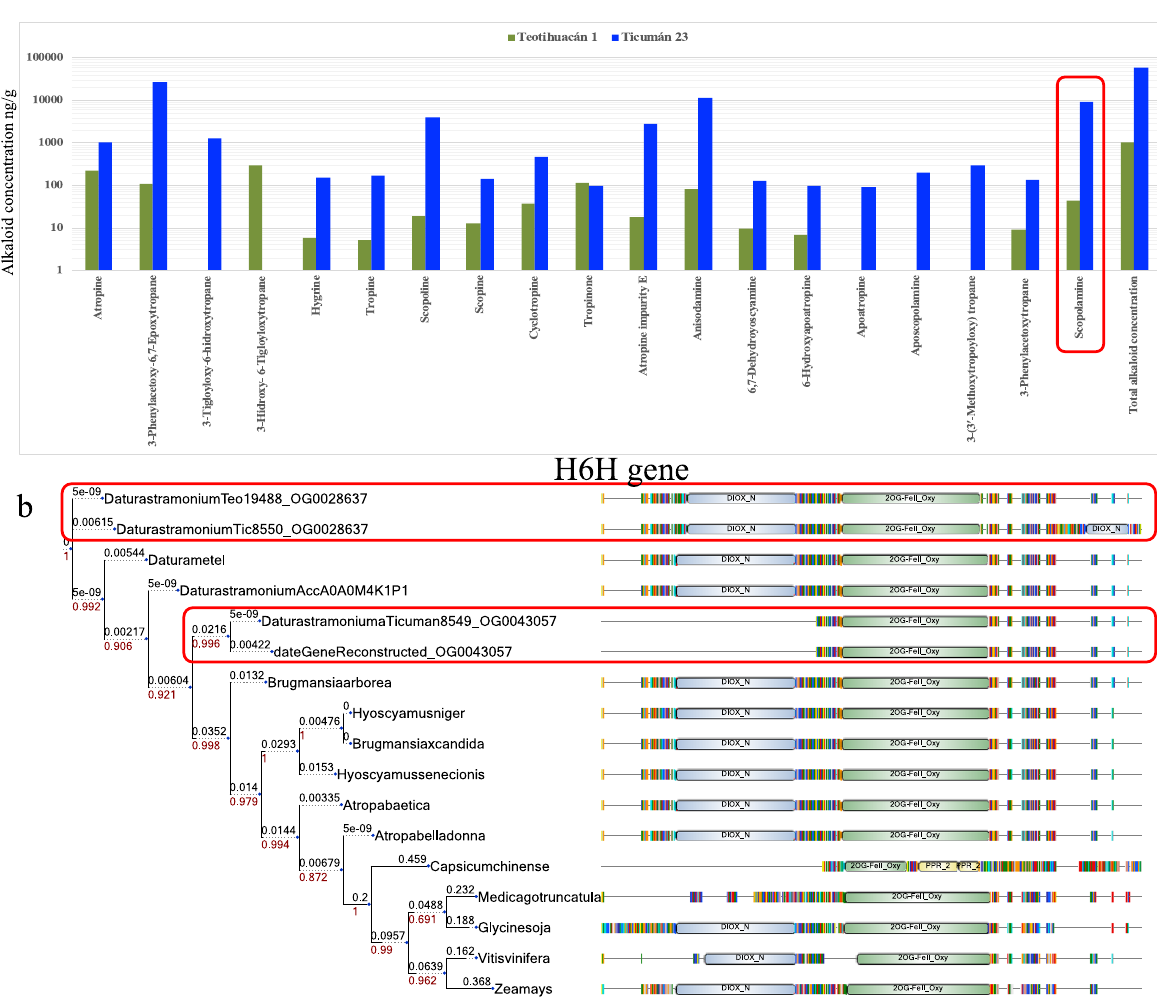
between Ticumán and Teotihuacán (Supplementary Table S17 online, Fig. 5a). Thus, it is possible that the additional domain of spermine-synthase confers overproduction of tropane alkaloids in the Ticumán genome. No expansion was detected for tpr I gene in D. stramonium (Supplementary Table S16 online). However, we observed four copies of this gene in both Datura genomes (Fig. 6). The gene date9161 (Teotihuacán) and dati33033 (Ticumán) have two domains absent in the other tpr I Datura genes; Sulfakinin (PF08257) and ECR1_N domain (PF14382) (Fig. 6). Wei et al. 52 found that the sulfakinins may reduce the sensitivity of taste receptor of Schistocerca gregaria (Acrididae). Here, we found that sulfakinin domain is observed in D. stramonium but not in the other Solanaceae species (Fig. 6). Likewise, ECR1_N is an N-terminal region of the exosome com- plex of resistance proteins 33 . The Datura tpr I genes date9170 and dati33044 had a domain architecture different from the tpr genes of the other studied Solanaceae (Fig. 6). However, the gene dati33044 (Ticumán) has one additional domain adh_short_C2 (PF13561), in comparison with its homolog date9170 (Teotihuacán) (Fig. 6). Likewise, dati33027 showed an additional adh_short_C2 domain in comparison with its homolog date20542 (Fig. 6). We observed that the Ticumán plant produced ca . 32 times more tropine than the Teotihuacán plant (Supplementary Table S17 online, Fig. 5 a). This chemical difference in tropine concentration could be related with this additional domain (adh_short_C2) that was observed in the Ticumán genome. It has reported that the domain adh_short_C2 plays a role as anti-microbial and anti-parasitic molecules 53 .